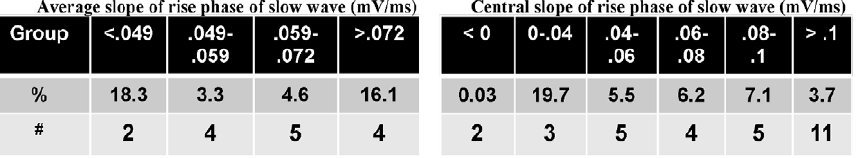
Figure 1. Levels of database segmentation based on single activity characteristics. (A) The first tier of this hierarchy includes all models in the database. These models are then divided into groups based on activity type. The second tier includes the groups periodic spiking, irregular spiking, silent, periodic bursting, irregular bursting, and one-spike bursting models. For each group, the number of models (shown in percent of database) and the number of correlations found within that group is shown. The groups ‘‘periodic spiking’’ and ‘‘periodic bursting’’ are further subdivided in the third tier. The spiking models are partitioned by spike frequency in Hz, and the bursting models are partitioned by duty cycle. (B) In addition to duty cycle, periodic bursting neurons were also partitioned based on the slope of the rising phase of their slow wave activity. Three measurement techniques and segmentation schemes were used, two are shown here. See methods.